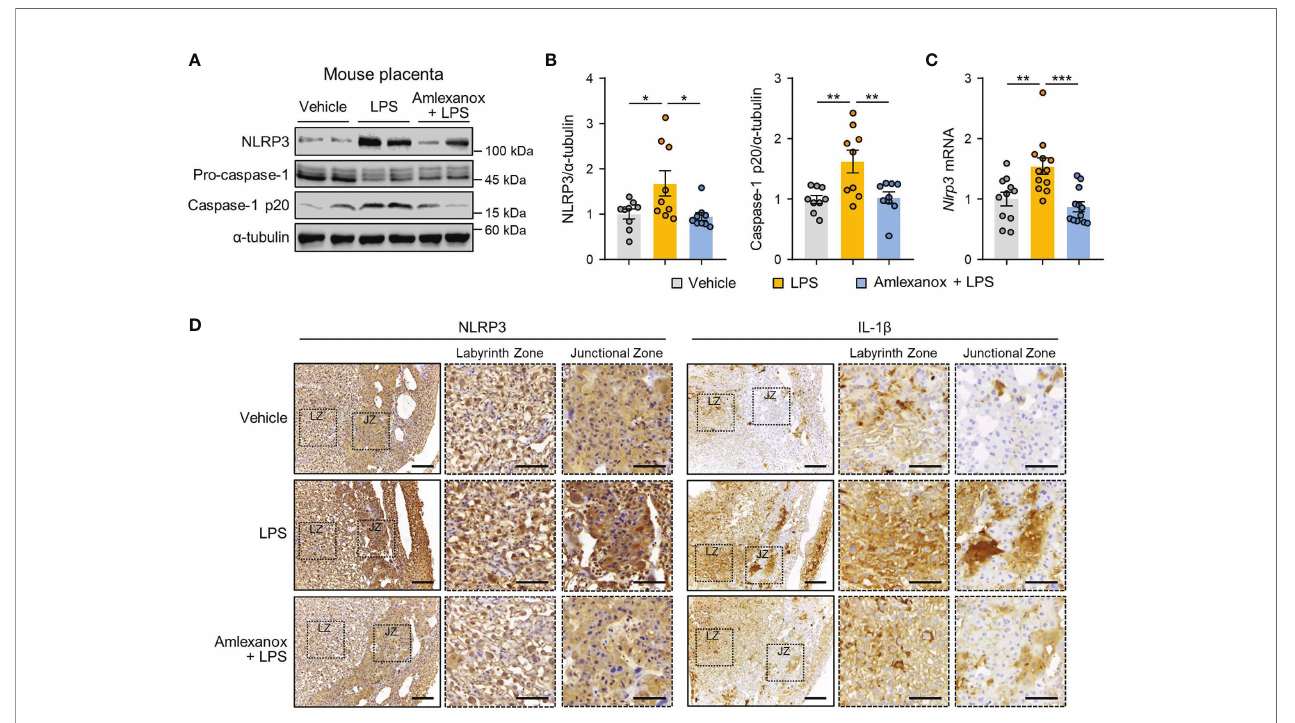
FIGURE 5 | Amlexanox ameliorates placental NLRP3 in fl ammasome activation in LPS-treated pregnant mice. (A – D) Pregnant mice were intraperitoneally injected with LPS (200 m g/kg) or amlexanox (2.5 mg/kg) on gestation day 17.5, as indicated in the fi gure. (A, B) Placental tissues were collected from mice and analyzed by immunoblotting with anti-NLRP3 and anti-caspase-1 antibodies ( n = 9 per group). a -tubulin served as a loading control. Band intensities were quanti fi ed and normalized to control band intensities. (C) Placental tissues were collected from mice and analyzed by qRT-PCR for the expression of NLRP3 ( n = 11 – 12 per group). (D) Immunohistochemical analysis of NLRP3 and IL-1 b in placental tissues from vehicle-, LPS-, and LPS+amlexanox-treated pregnant mice at gestation day 17.5. Nuclei were stained with hematoxylin. Boxed areas are magni fi ed in the adjacent panels. LZ and JZ represent the labyrinth zone and the junctional zone, respectively. Scale bars, 200 m m; inset, 100 m m. Data are shown as means ± SEM. * p < 0.05; ** p < 0.01; *** p < 0.001 (One-way ANOVA, followed by Tukey ’ s